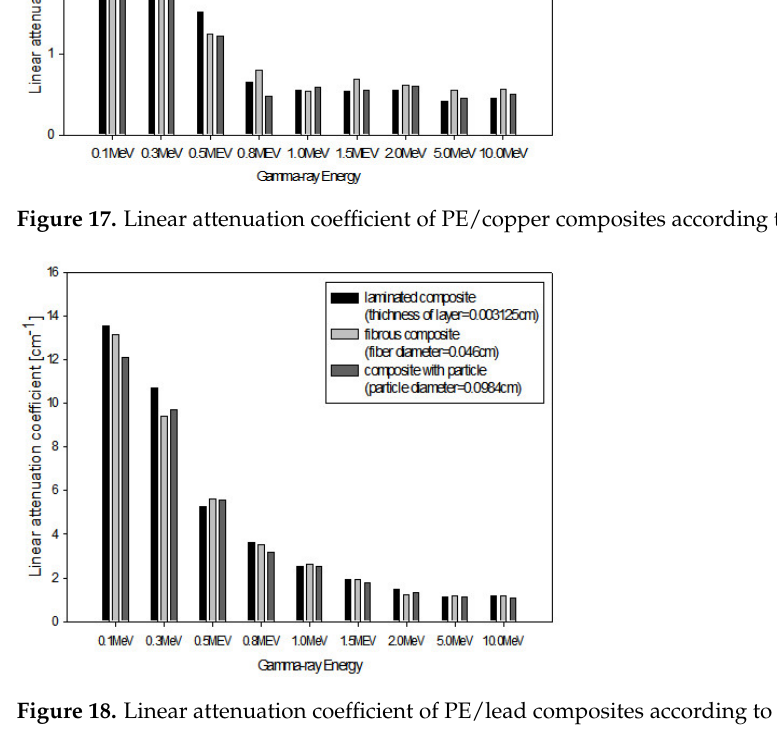
Figure 19. Linear attenuation coefficient of PE/tungsten composites according to composite struc- ture. 7. Linear Attenuation Coefficient of Cesium Adsorbed Nonwoven Fabric Since the cesium adsorption nonwoven fabric does not have a simple internal struc- ture and has a very wide irregular interface, attenuation of gamma rays can be expected even if the shielding effect due to the material is not great. Based on the previous results,